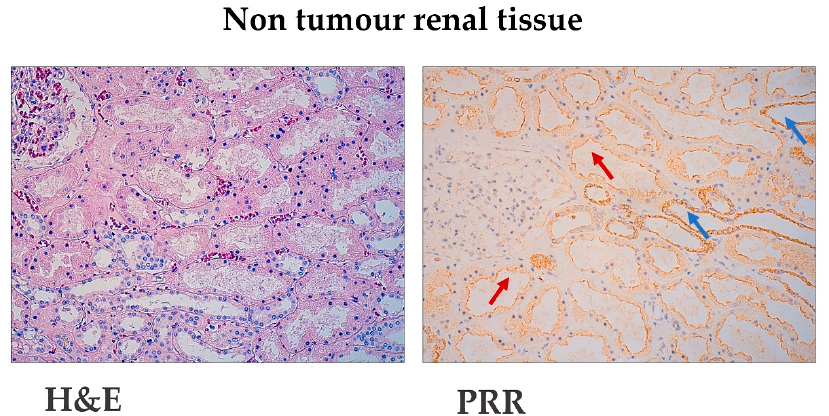
Figure 1. Immunohistochemical (Pro)renin Receptor (PRR) staining in non-tumour renal tissue. Hematoxylin–Eosin and PRR immunostaining at the uninvolved part of the kidney. Original magnification, ×250. Red arrows point to proximal tubules with weak PRR expression. Blue arrows point to distal nephron tubules with intense PRR staining.